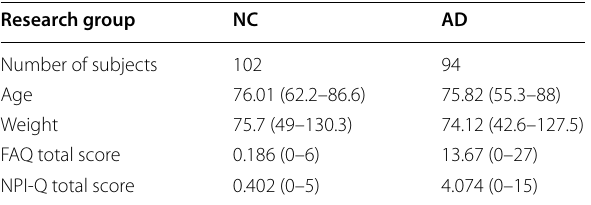
Table 1 Demographics of subjects with PET scans presented in